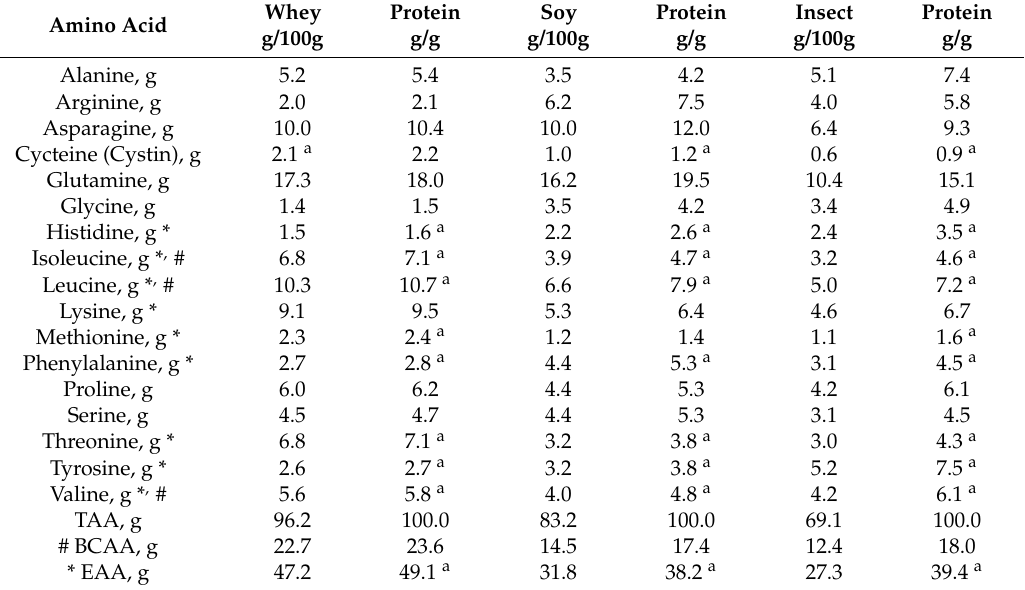
g/g protein) for adults. In addition, whey and insect protein met all requirements for each EAA, while soy protein did not meet the requirements of methionine (1.6 g/g protein), (Figure 4). Table 2. Total amino acid content (TAA), branched-chain amino acid (BCAA), essential amino acid (EAA). Amino acid content evaluated as AA g/100 g and AA g/g protein. Tryptophane content was not measured.